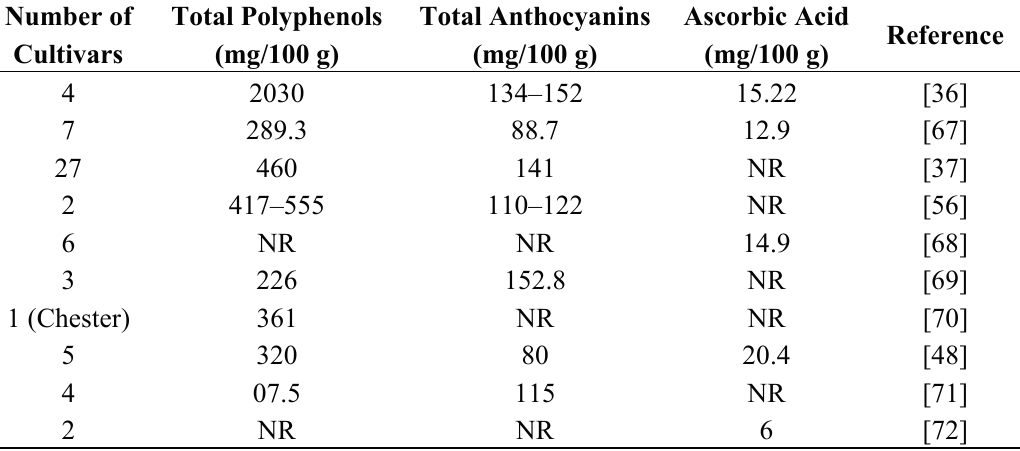
Table 10. Total polyphenols, total anthocyanins and ascorbic acid in blackberry.